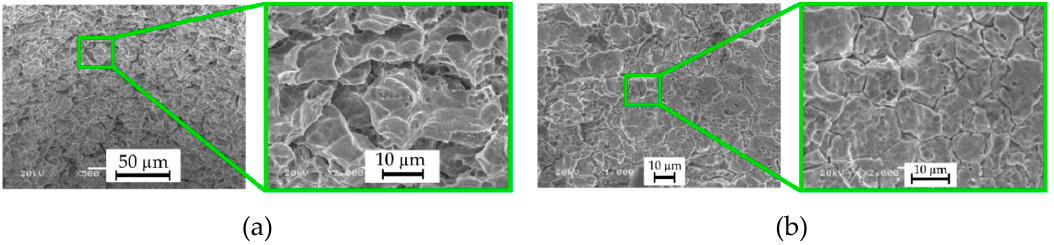
Figure 22. SEM images of (a) the inner surface of the hole (hole No. 3) and (b) the surface after electrochemical dissolution with the use of deionized water (machining parameters: U = 25 V, t i = 300